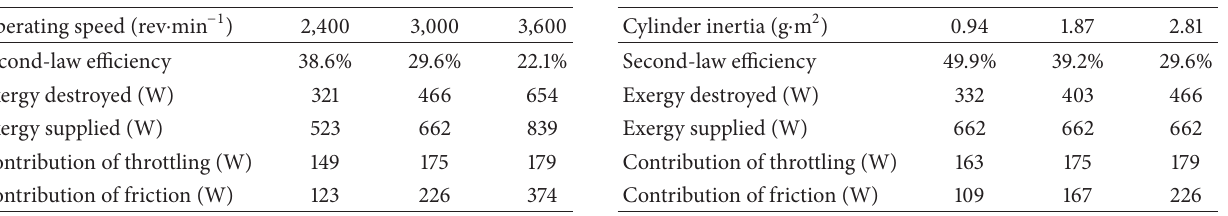
Table 4: Data of variation of operating speed. Table 5: Data of variation of cylinder